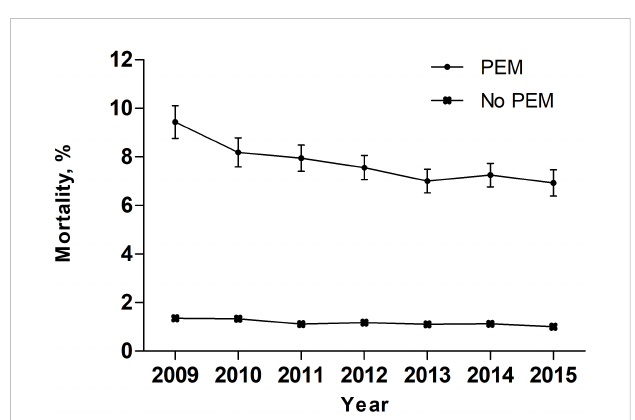
FIGURE 3 Mortality in patients with and without PEM between 2009 and 2015 in the United States.